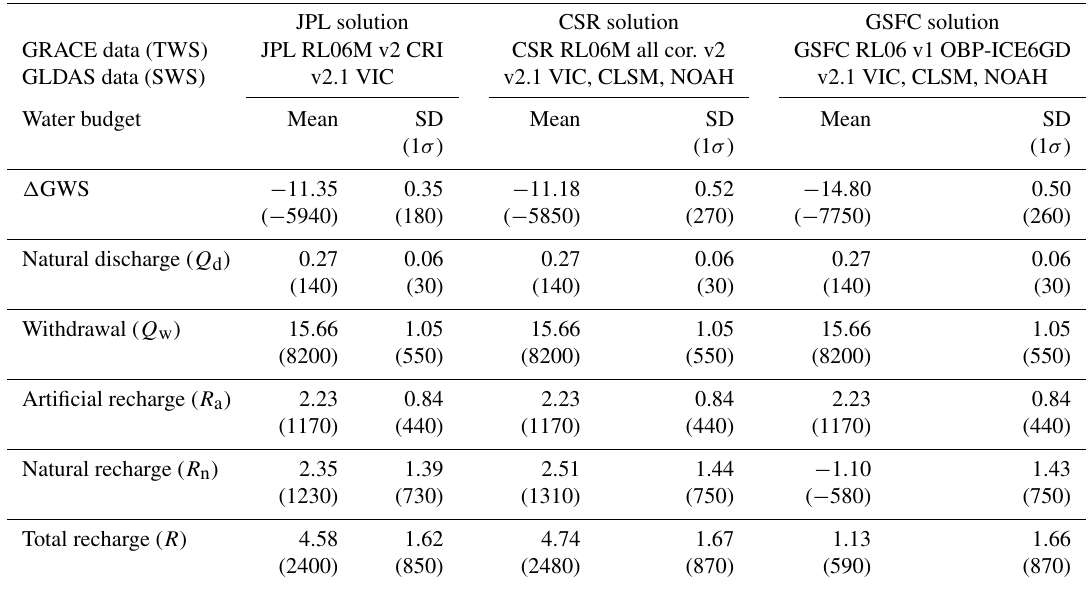
GRACE–GLDAS solutions (and associated standard deviation (SD) 1 sigma) for the 2002–2019